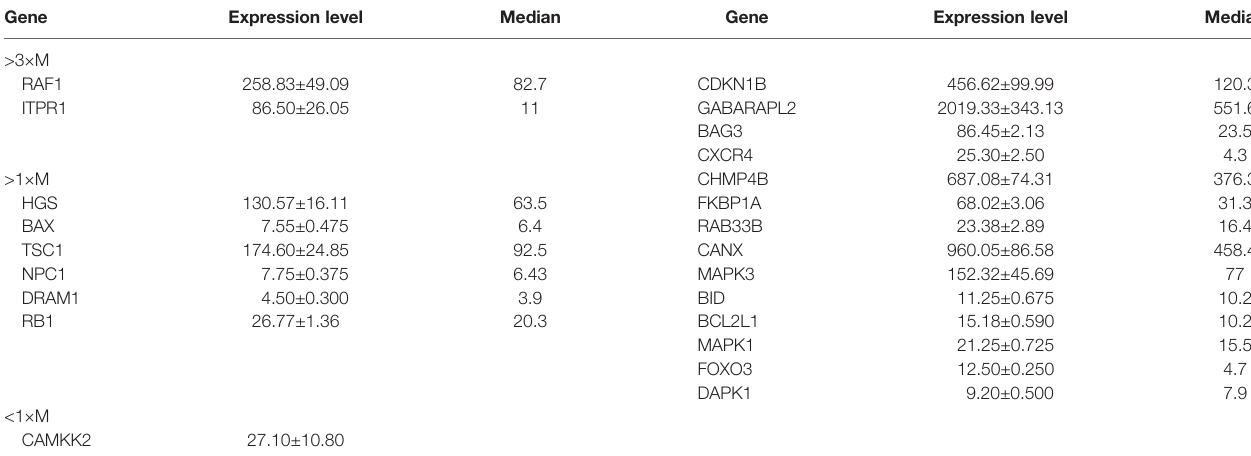
TABLE 2 | Expression levels of dierentially expressed genes identi fi ed by BioGPS in retinal tissues.